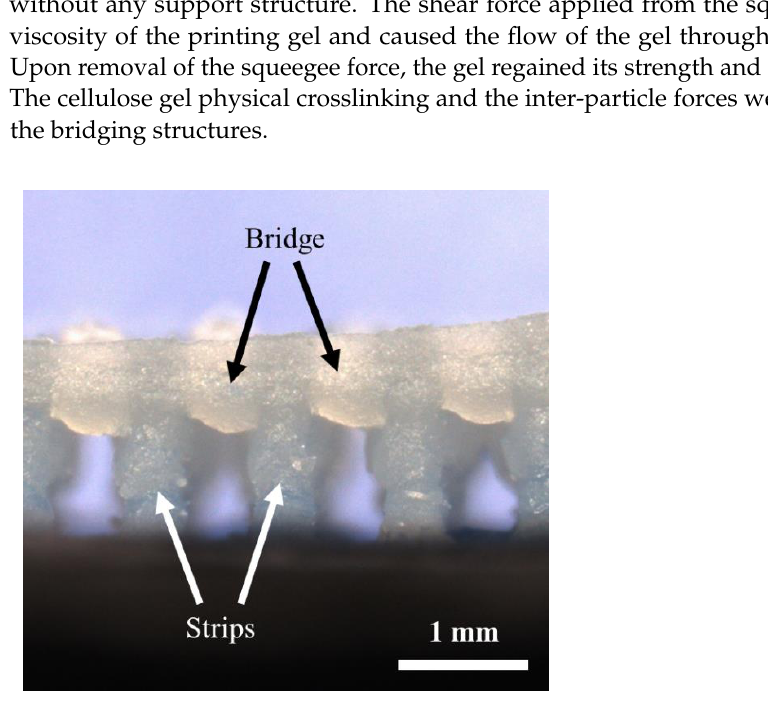
Figure 9. Side view of a SAM cellulose gel, showing strips and bridges.